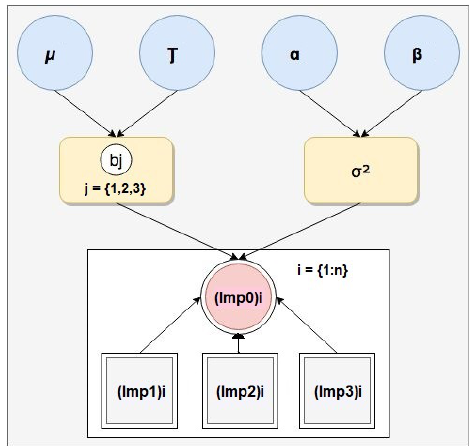
Figure 4. The graphical representation of the statistical Z P or Z S